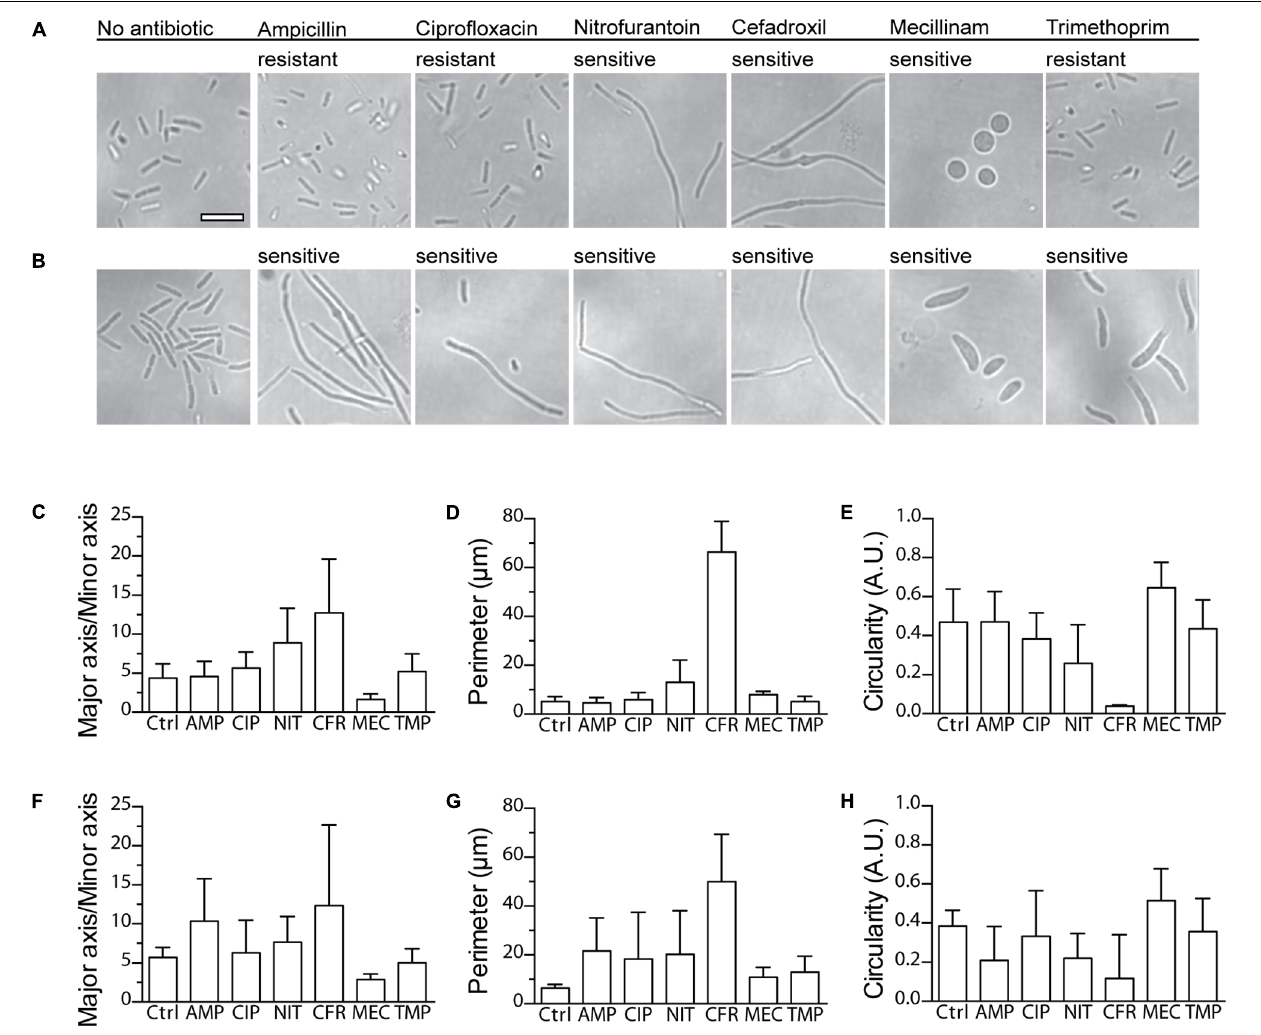
FIGURE 3 | Imaging and morphotypic quantification of bacterial morphologies upon exposure to antibiotics. Phase contrast microscopy of the clinical UPEC isolates (A) ARD311 and (B) ARD318 in the nwAST shows the bacterial morphology after 3 h exposure to MIC (sensitive isolates) or breakpoint (resistant isolates) concentrations of each antibiotic. Scale bar = 5 µ m, applies to all micrographs. Quantification of morphotypic parameters for strain (C–E) ARD311 and (F–H) ARD318 upon exposure to ampicillin (AMP), ciprofloxacin (CIP), nitrofurantoin (NIT), cefadroxil (CFR), mecillinam (MEC), and trimethoprim (TMP). Morphotypic parameters of major to minor axis, perimeter, and circularity were calculated based on image analysis from four technical replicates per antibiotic. The average and standard deviation is shown. Ctrl = no antibiotic